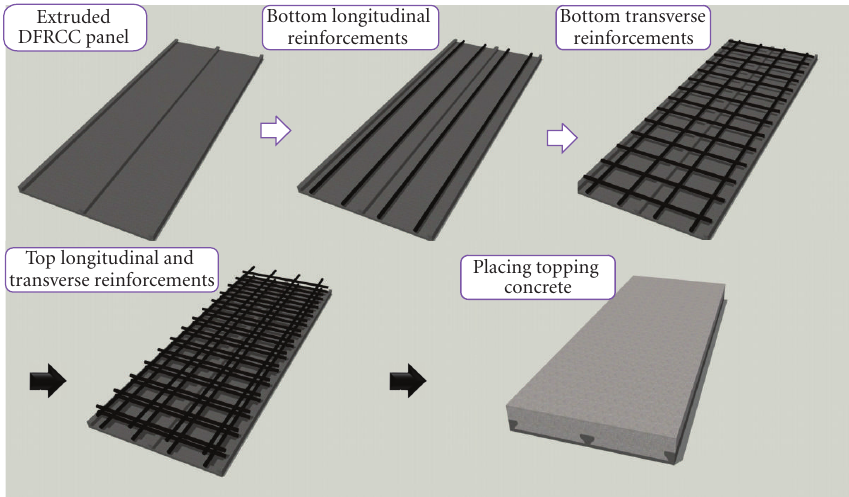
Figure 7: Schematic construction process of slab system.